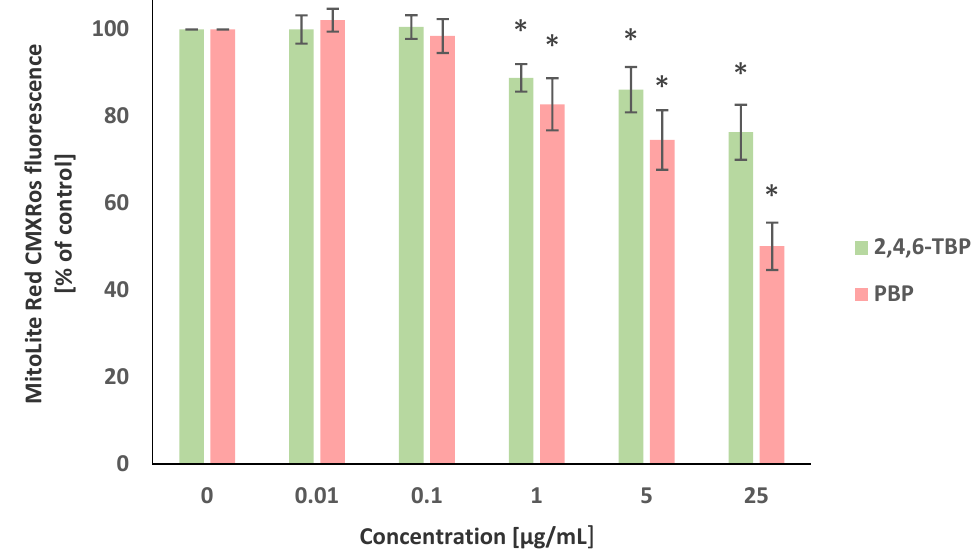
Figure 3. Changes in transmembrane mitochondrial potential ( ∆Ψ m ) of PBMCs incubated with 2,4,6-TBP and PBP in concentrations ranging from 0.01 to 25 µg/mL for 24 h. Means ± SDs were calculated from four individual experiments (four blood donors). Results were statistically different from negative control at * p < 0.05. Statistical analysis was conducted using one-way ANOVA and a posteriori Tukey